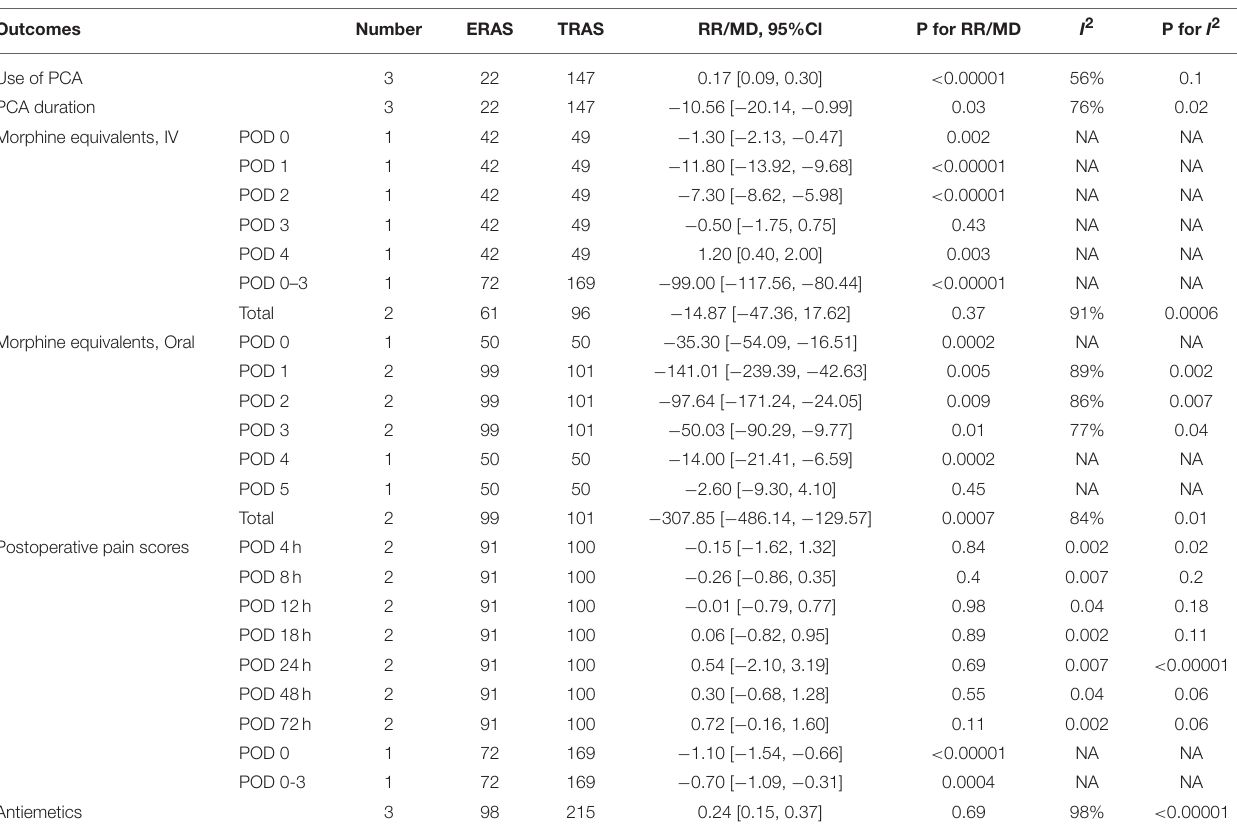
TABLE 3 | The meta-analysis results of PCA usage and duration, intravenous injection, and oral morphine consumption; postoperative pain scores; and antiemetic consumption. Outcomes Use of